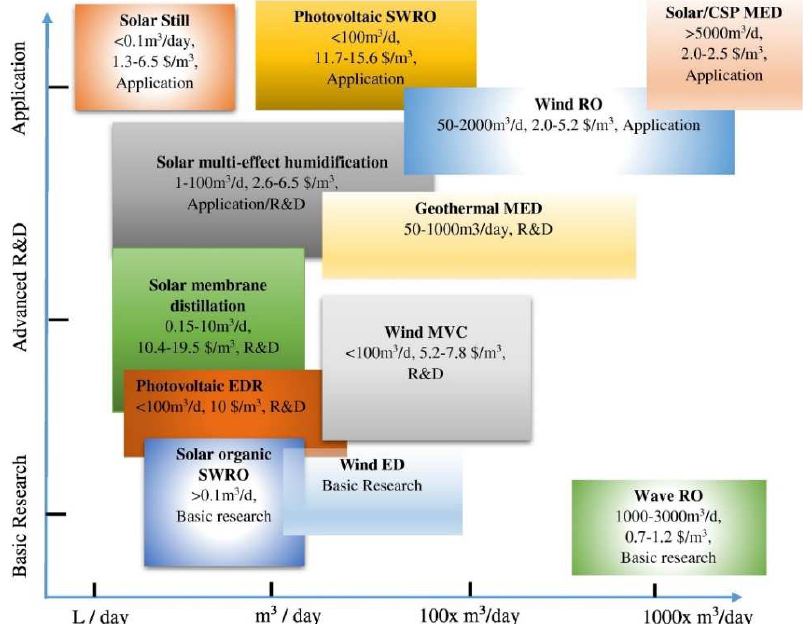
Figure 1. The technological state of desalination technology for renewable energy. Reproduced with permission from. Reproduced with permission from Farah Ejaz Ahmed, Raed Hashaikeh, Nidal Hilal, Desalination Journal, published by Elsevier, 2019 [10].